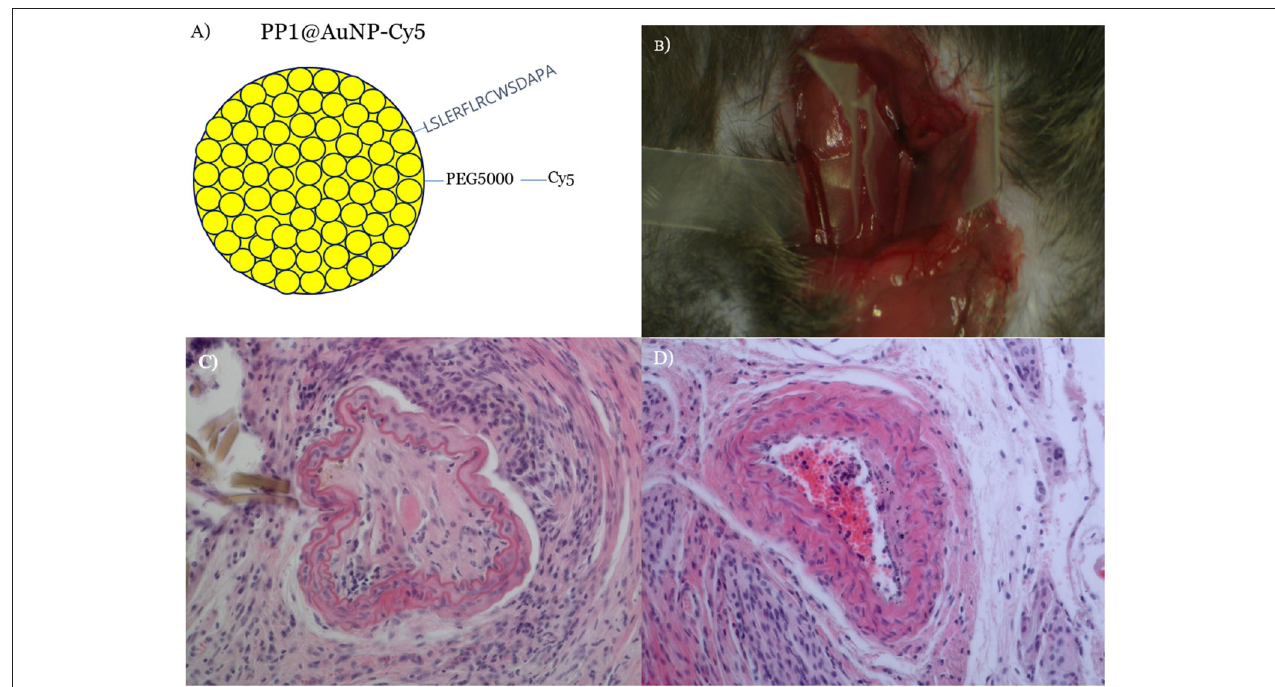
FIGURE 5 | SR-A1-binding PP1@AuNPs were prepared (A) and delivered via IV in a carotid artery-ligated atheromatous mouse model (B) . Proton-TIBS (4Gy) induced flow recovery by reducing plaque and preserving the normal structure of blood vessels (D) compared with the untreated obstruction control (C) . The patency of the